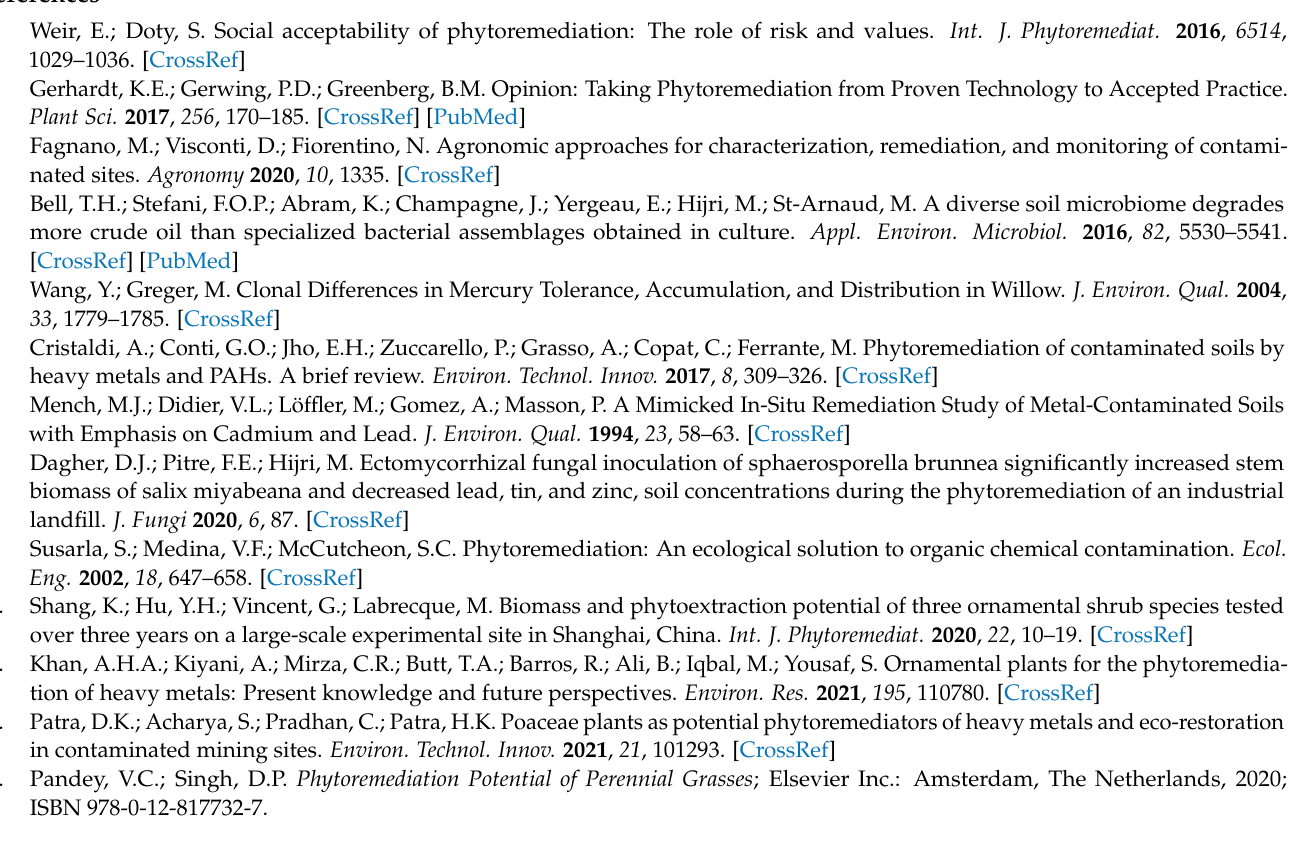
Table S3: Seasonal variation (SV) of soil PCBs, C10-C50, PAHs and